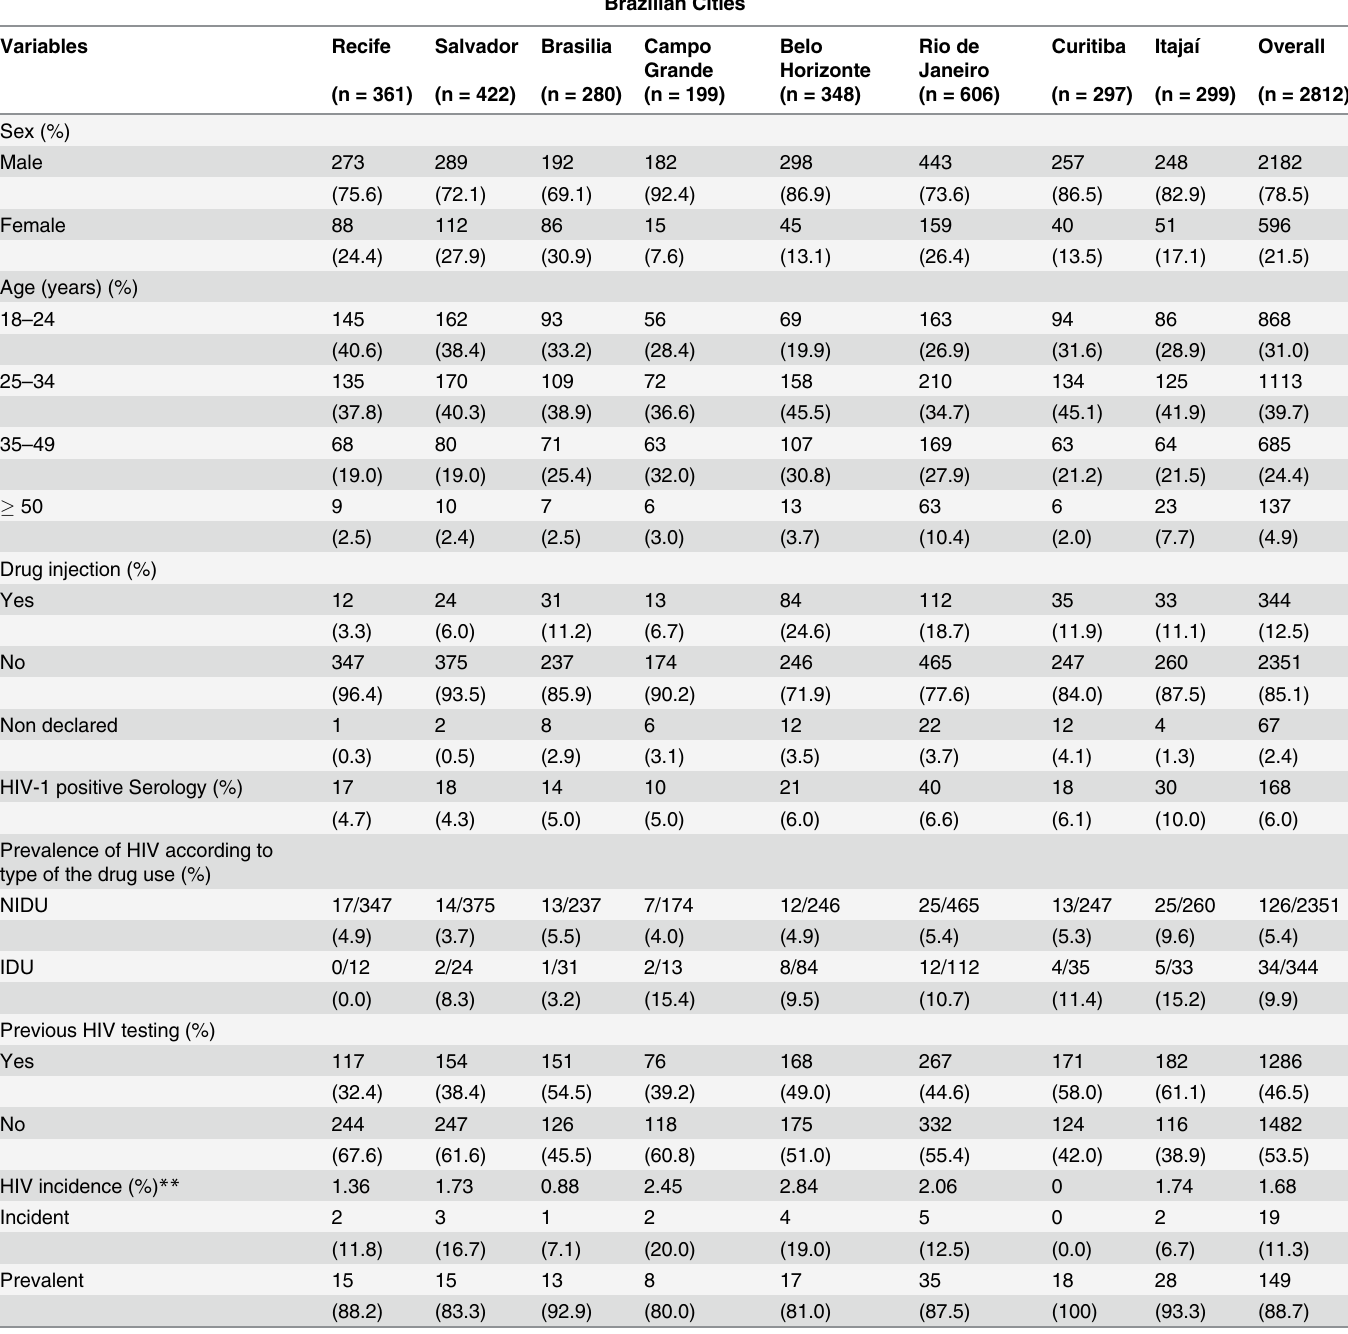
Table 1. Socio-demographic and clinical characteristics of drug users recruited by RDS method and screened to HIV in eight Brazilian cities,